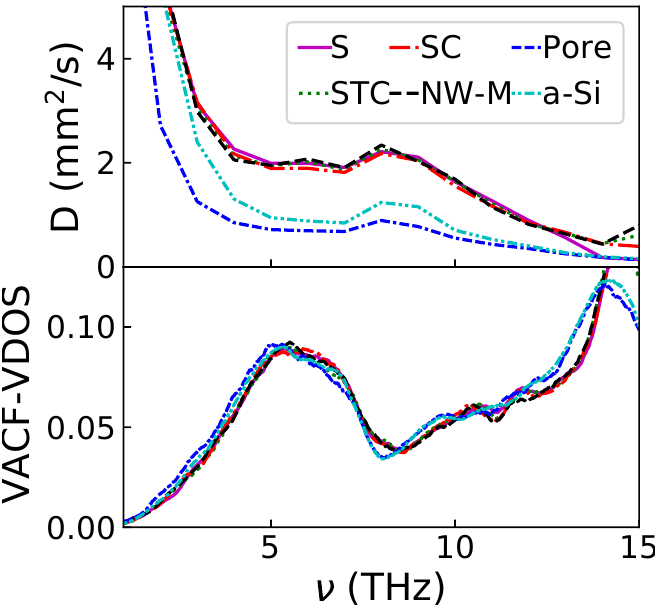
Figure 4. Diffusivity and VDOS as a function of frequency for the studied